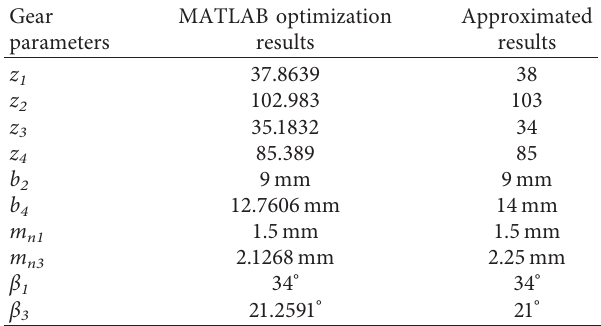
Table 11: Gear parameters’ optimization